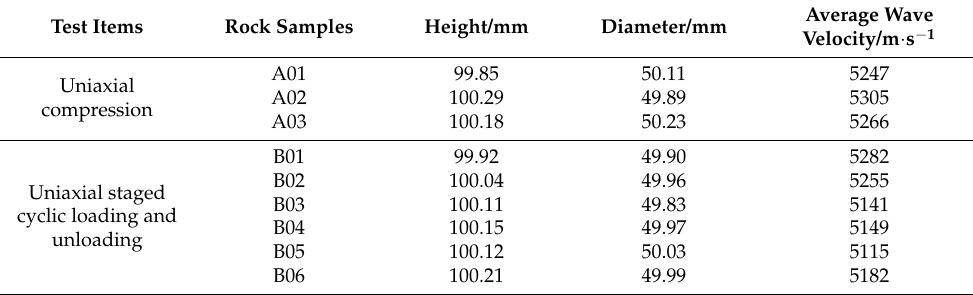
Table 1. Basic parameters of test rock samples.